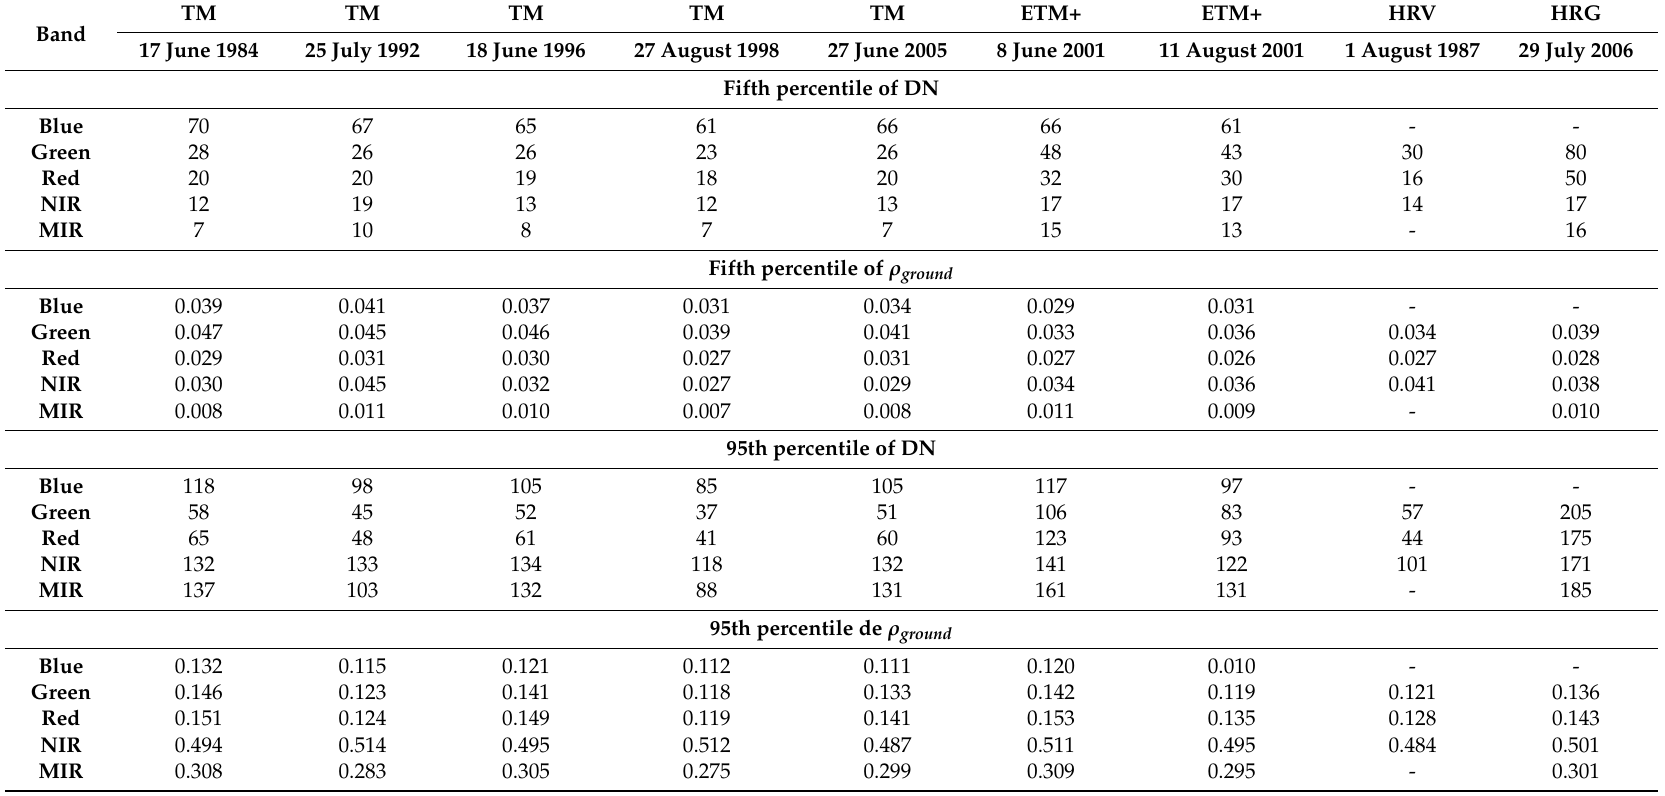
Table 3. The fifth and 95th percentiles of DNs and ground reflectances for Landsat and SPOT